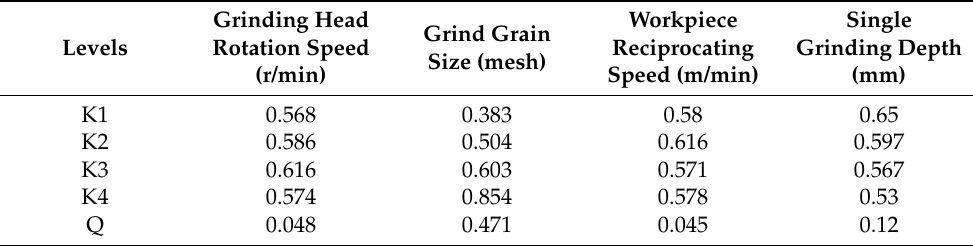
Figure 7. Cylindricity of different extensions. 4. Response Surface Regression Earlier in the article, we qualitatively analyzed the association between honing parameters and response Ra values based on grey correlation analysis, and also obtained the optimized parameter combinations. However, experimental parameters that are outside the orthogonal experiment cannot be performed in the orthogonal experiment. Response surface methodology (RSM), an experimental method suitable for nonlinear mathematical models, considers experimental random errors and fits complex unknown functional relations with polynomial functions. Therefore, the RSM was further used to explore the relationship between each parameter and Ra value. Then, a response surface regression mathematical model was established, and the exact value of surface roughness was obtained. 4.1. Theoretical Analysis RSM is the product of a combination of mathematical and statistical methods, using regression methods to approximate the relationship between input and output quantities by means of polynomials [25]. Then, the functional relationship is established to quantitatively analyze the effect of input quantities and their interactions on the output values. The ultimate goal is to optimize that output value. Its second-order polynomial is based on the expansion of Taylor’s formula, which extends from a single variable to multiple variables. The specific formula is shown in Formula (7) [26]: k